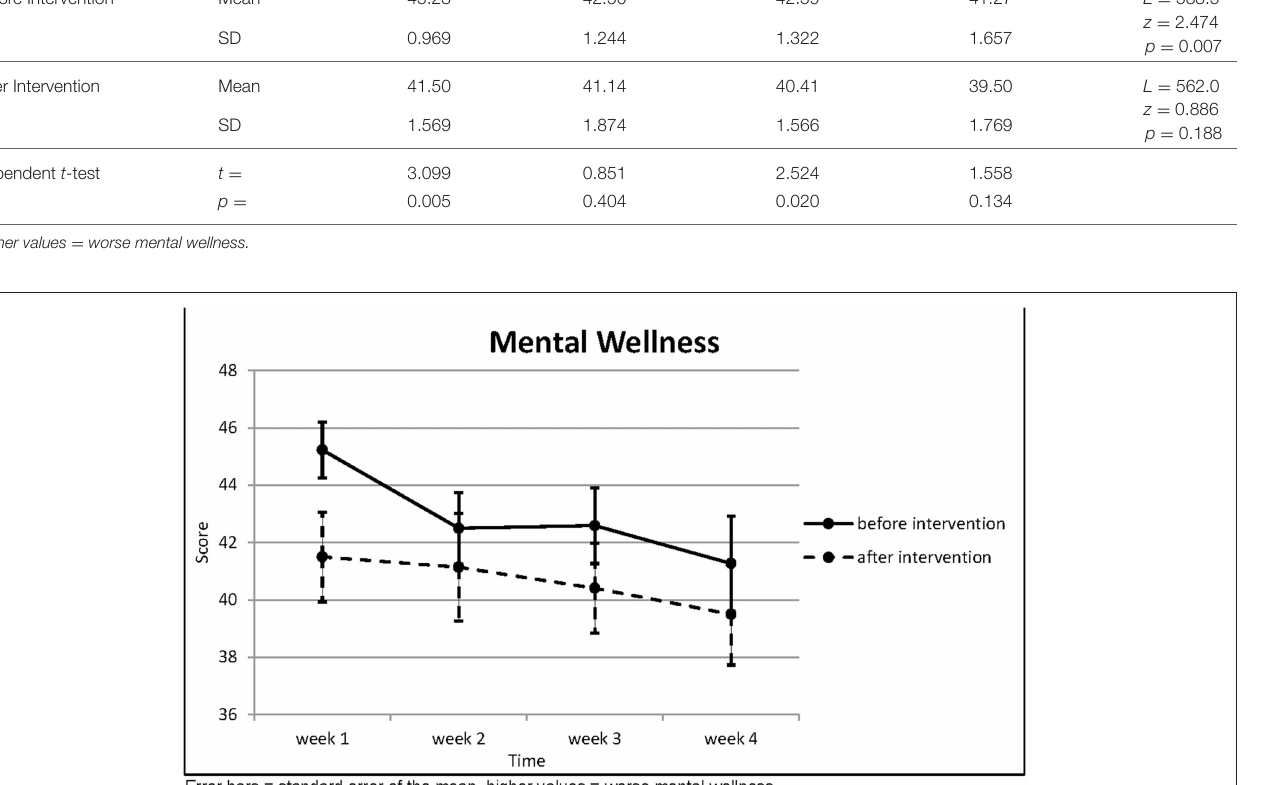
FIGURE 5 | Questions about Mental